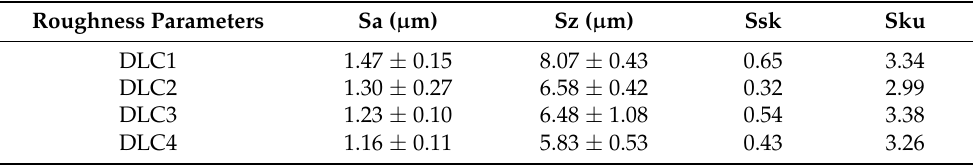
Table 8. Area surface roughness parameters after laser stripping of DLC C coating.